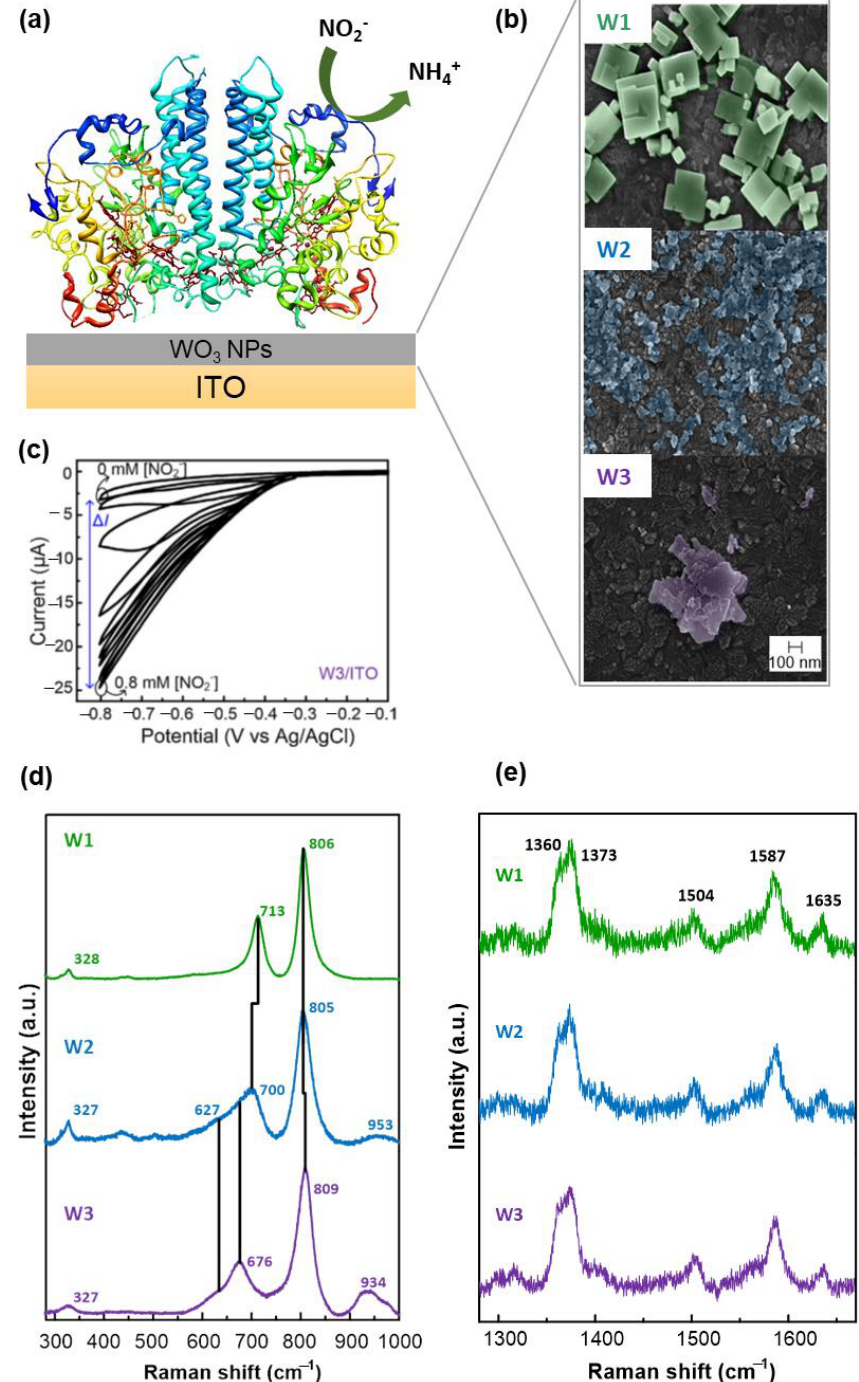
Figure 9. Electrochemical and spectroscopic characterization of a cytochrome c nitrite reductase (c c NiR)/WO 3 nanoparticles (NPs)/indium tin oxide (ITO) biosensor. ( a ) Schematic representation of the enzyme/electrode construct showing the catalytic conversion of nitrite into ammonium; ( b ) scanning electron microscopy (SEM) images of three different hydrothermally synthesized WO 3 NP samples (W1, W2, and W3); ( c ) cyclic voltammetry response obtained upon addition of increasing nitrite concentration; ( d ) Raman spectra of WO 3 NPs samples; ( e ) resonance Raman (RR) spectra of c c NiR immobilized on the WO 3 NPs/ITO electrodes. Reprinted from Santos et al. [125], Copyright (2016), with permission from Elsevier.